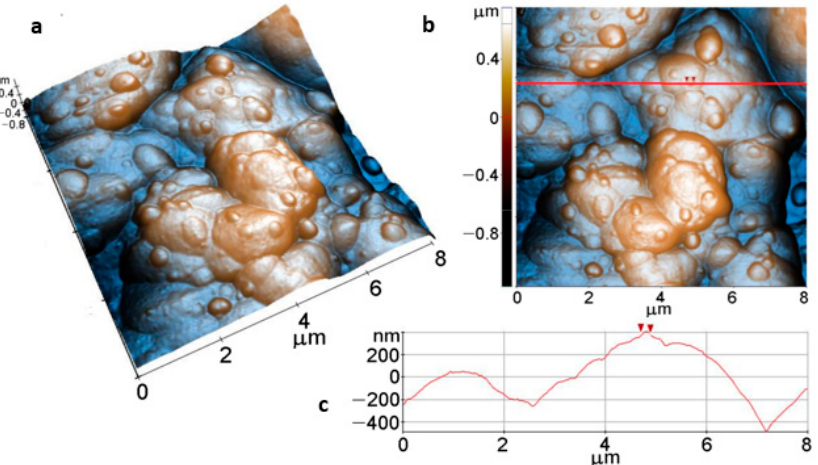
Figure 9. Tri-dimensional ( a ), bi-dimensional ( b ) AFM images taken on areas of 8 µm × 8 µm and AFM line profile ( c ) of Mg after immersion for 15 min, along the scanning direction marked to guide the eye by the red line in ( b ).